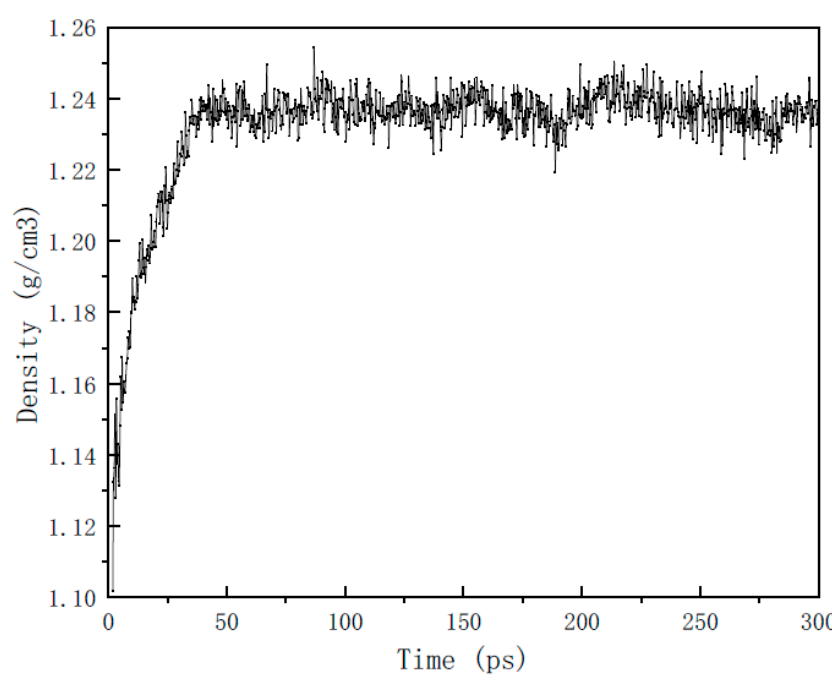
Figure 3. Change of calculated density with time.